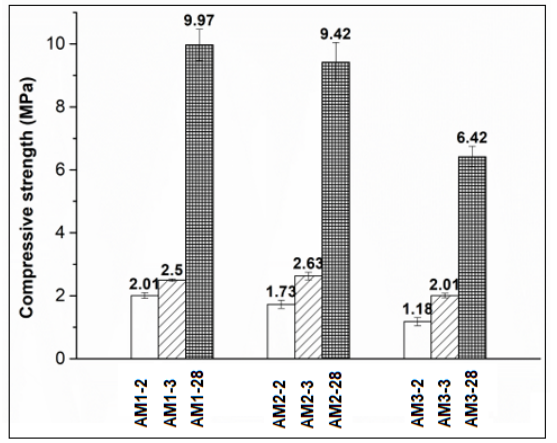
Figure 8. Compressive strength of alkali-activated metakaolins .